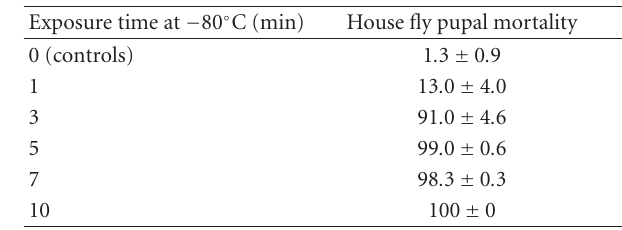
Table 2: Mean ± SE house fly mortality (%) after cold treatment for determination of lethal level of